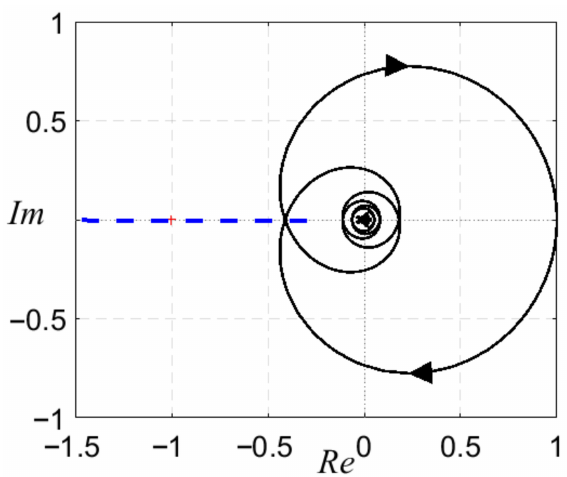
Figure 7. A graph of the equation’s solution (2). The dashed line is the function − 1/ N ( A ) , whereas the continuous curve is a Nyquist plot of L ( j ω ) with τ = 0.6 ms.